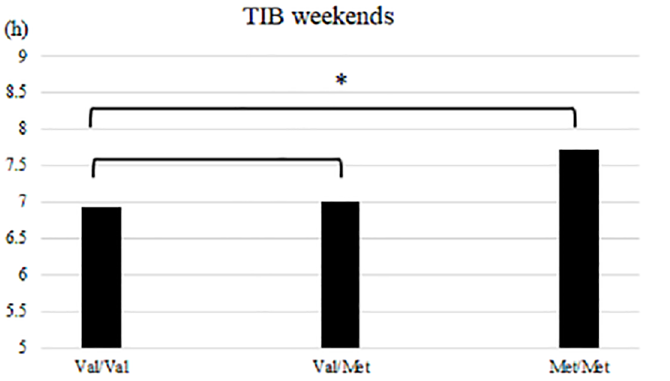
Fig 2. A significant difference was found for TIB on weekends between Val homozygotes and Met homozygotes.